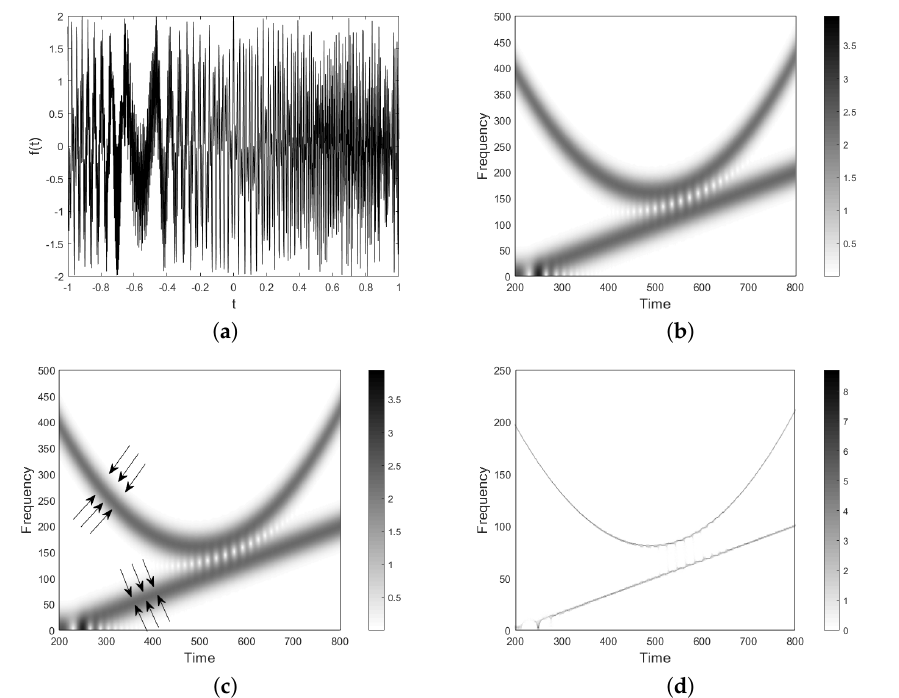
Figure 1. ( a ) Two-component signal whose IFs satisfy the separability condition; ( b ) Signal spectrogram; ( c ) Idea of reassignment: arrows provide the direction of spectrogram reassignment; ( d ) Reassigned